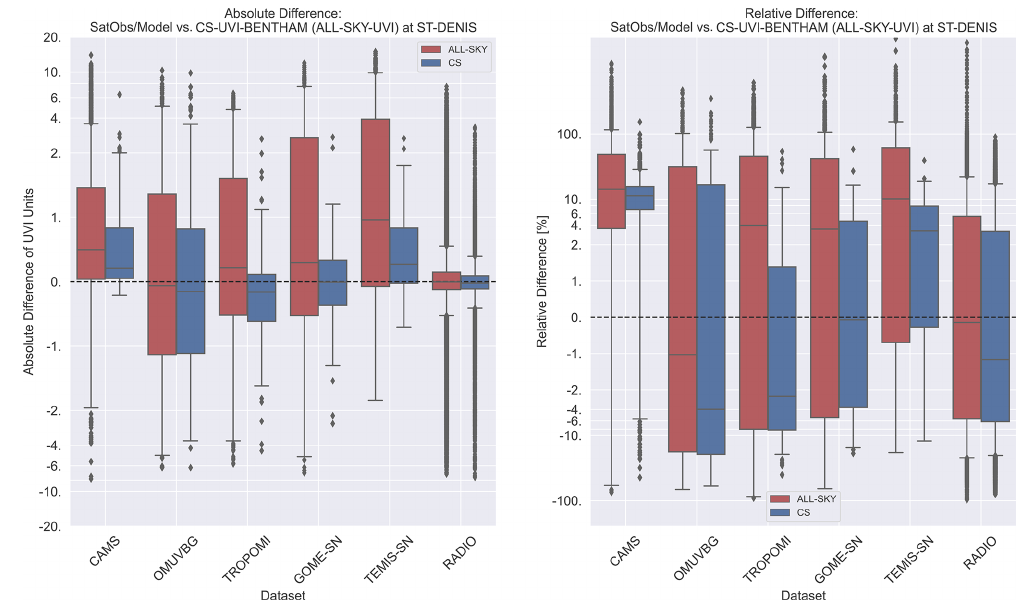
Figure A2. Boxplot of differences between UVI-RADIO and satellite/model estimates at Saint-Denis.